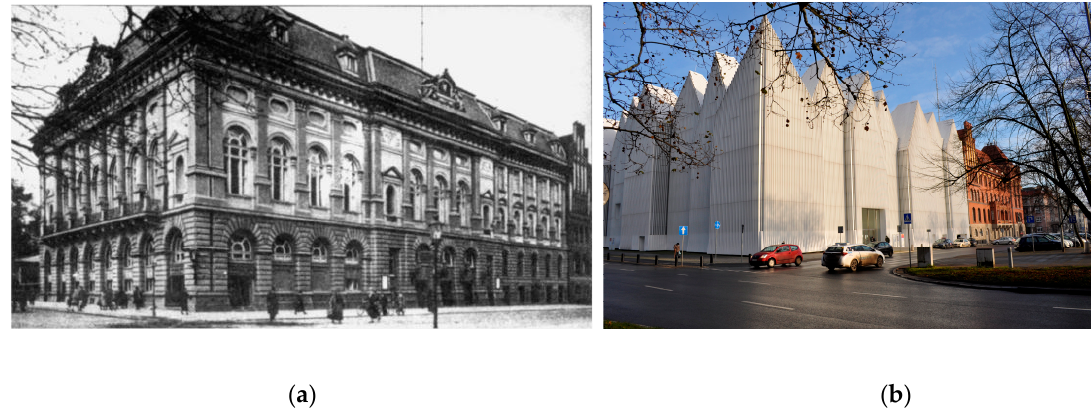
Figure 4. Plac Solidarno ś ci in Szczecin, with both photos taken from a similar perspective: ( a ) before 1939, Konzerthaus (source: sedina.pl); ( b ) today, the Mieczys ł aw Kar ł owicz Philharmonic Orchestra House (source: created by author). (source: sedina.pl); ( b ) today, the Mieczysław Karłowicz Philharmonic Orchestra House (source: created by